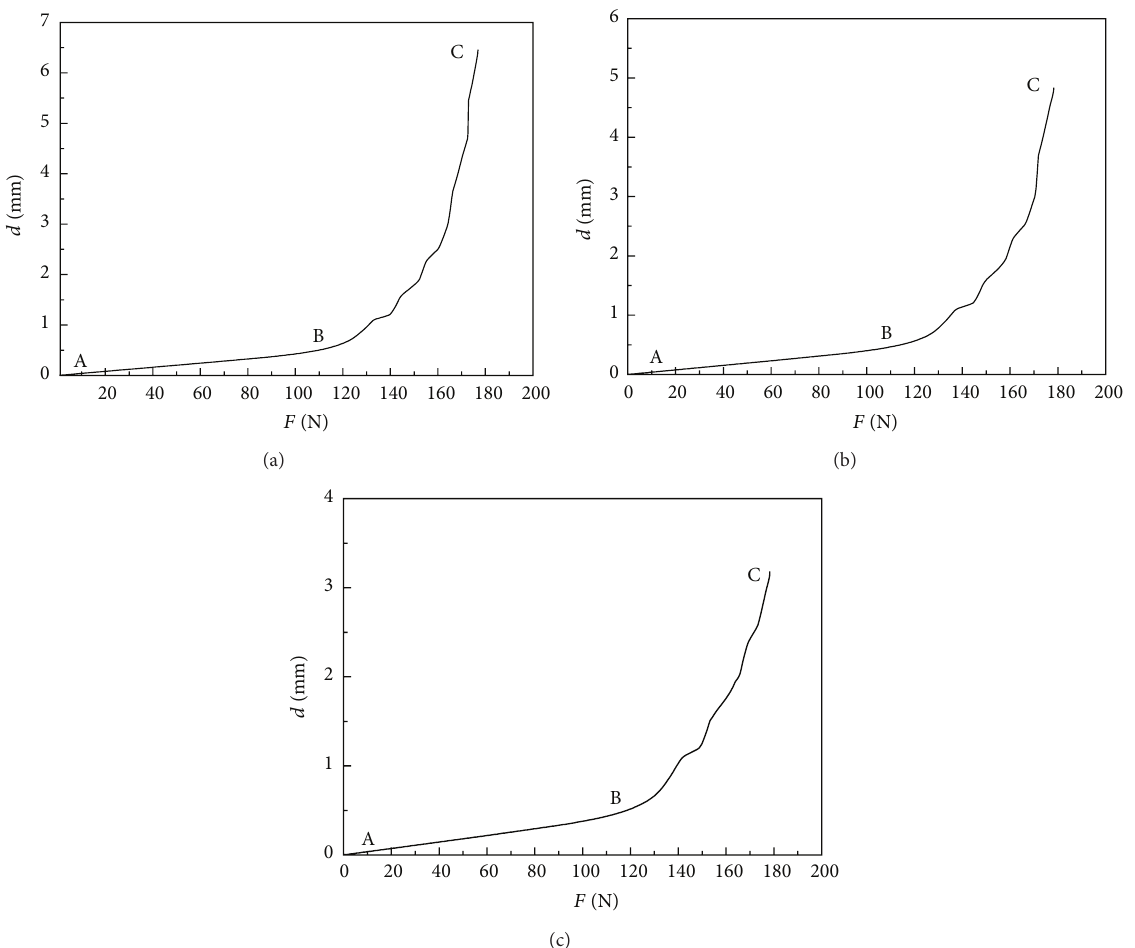
Figure 8: The relationship between the bending deflection ( 𝑑 ) and the applying load ( 𝐹 ) under different friction forces. (a) The contact friction coefficient is 0. (b) The contact friction coefficient is 0.25. (c) The contact friction coefficient is